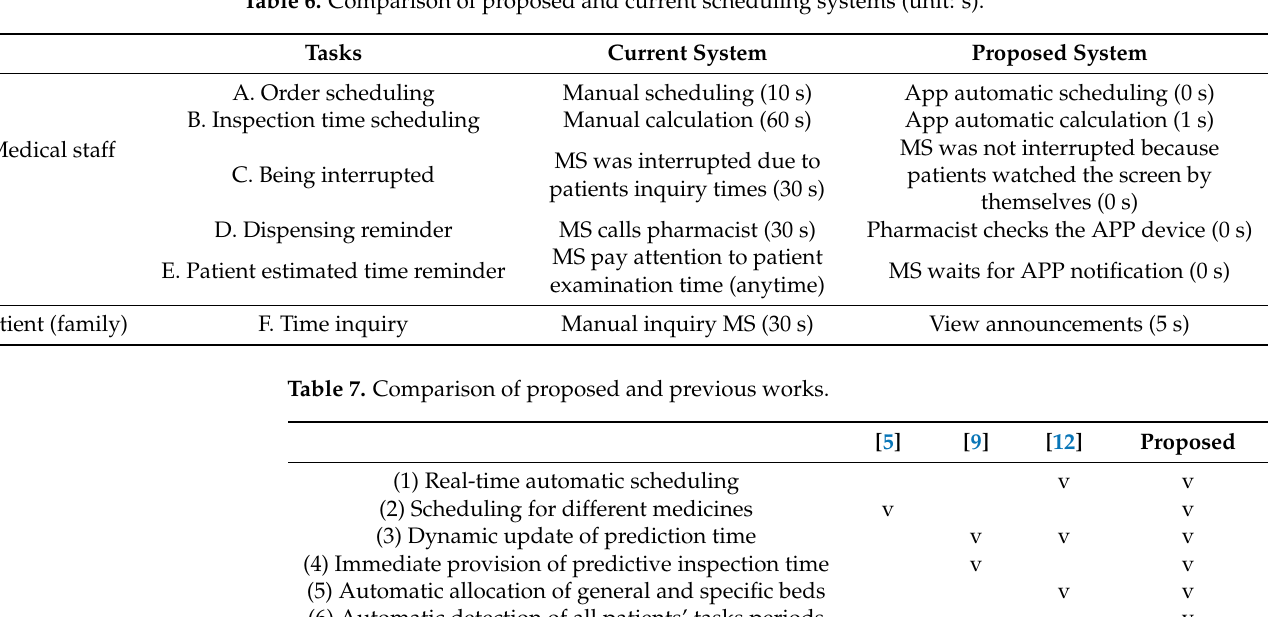
Table 6. Comparison of proposed and current scheduling systems (unit: s).